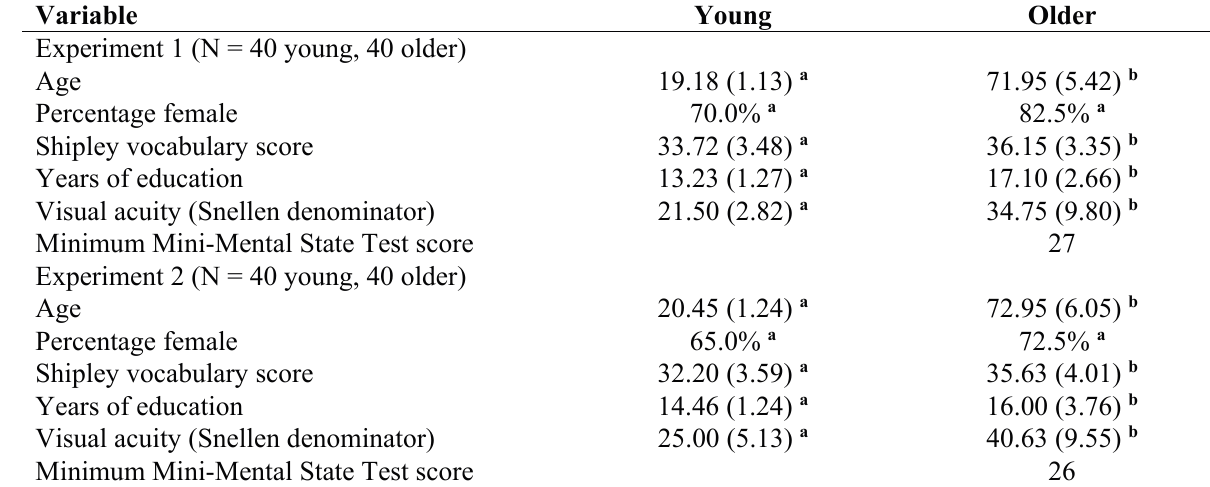
Table 1. Background characteristics of participants in Experiments 1 and